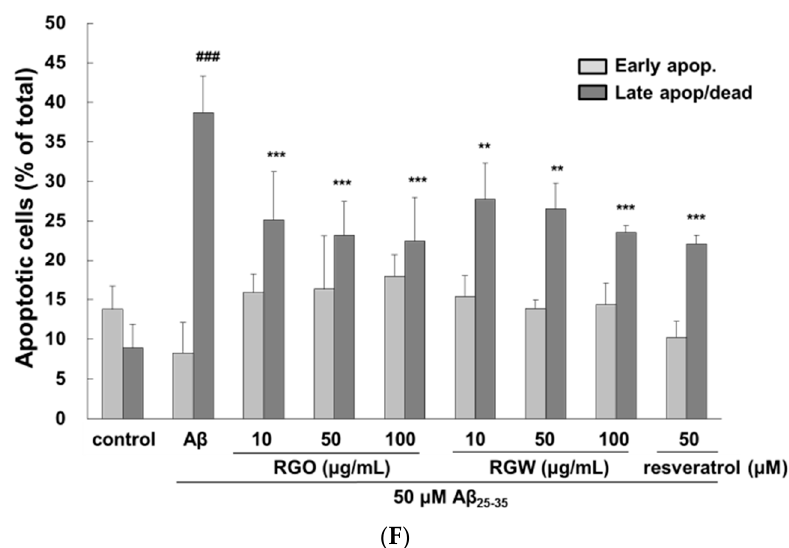
Figure 2. RGO and RGW inhibited A β 25–35 -stimulated intracellular reactive oxygen species (ROS) and apoptosis. PC12 cells were treated with samples for 1 h (10, 50, and 100 μ g/mL) and further added with A β 25–35 for 24 h. ROS generation of PC12 cells observed with CM-H2DCFDA (×400) ( A ) and measured by microplate reader ( B ). PC12 cell apoptosis was stained with Hoechst 33342 and imaged by fluorescence microscopy ( C ). Quantification of apoptotic cell ( D ). The flow cytometry images of apoptosis observed with Annexin V-7AAD ( E ). Percentage of early and late apoptotic cells ( F ). ### p < 0.001 compared to control group; *** p < 0.001 and ** p < 0.01 compared to A β 25–35 alone (ANOVA followed by Duncan’s multiple comparison test). Resveratrol was used as a positive control.